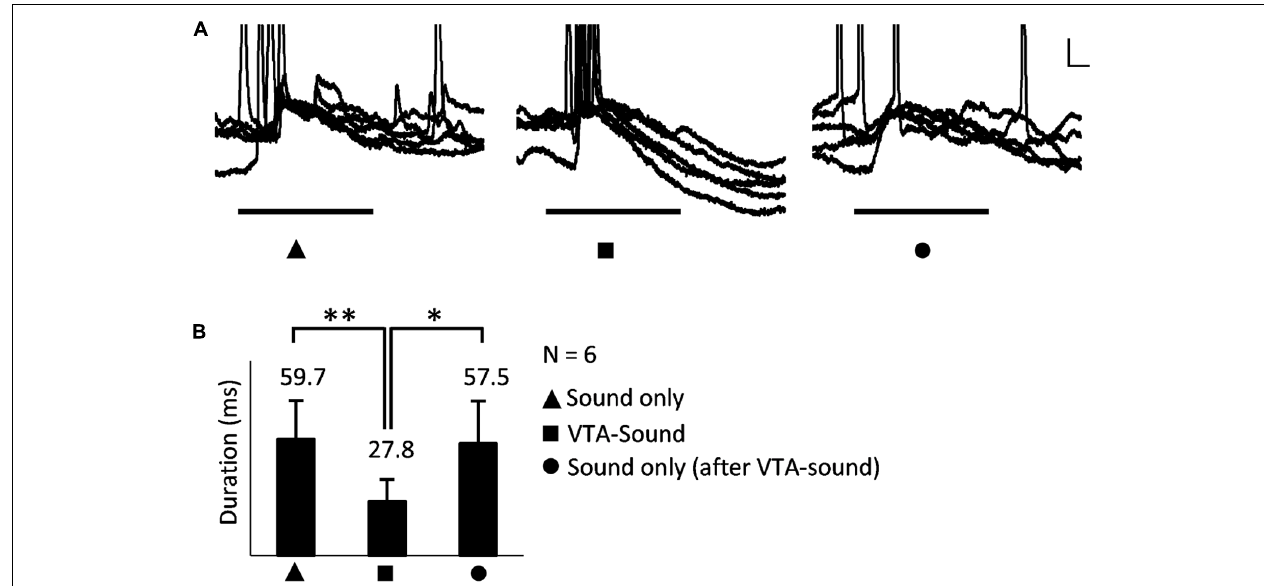
evoked response in A1 neuron was not significantly different from the duration when sound-only stimulation was first applied (* p < 0.05; ** p < 0.01, paired t -test; filled triangle: sound-only stimulation; filled square: paired VTA-sound stimulation; filled circle: sound-only stimulation that was delivered again after paired VTA-sound